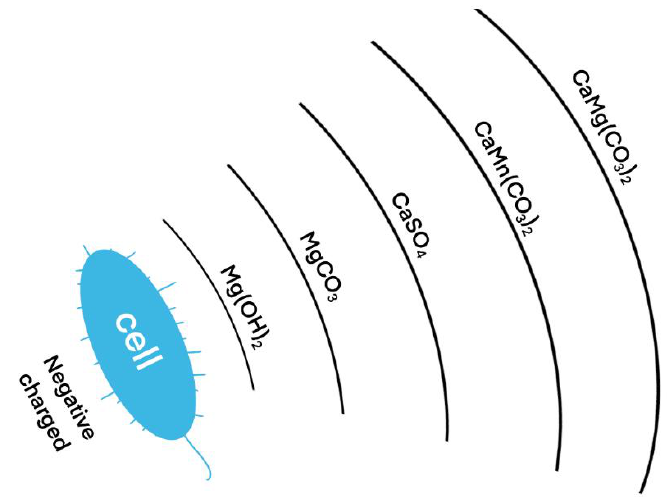
Figure 13. Hypothetical diagram of multilayer precipitation structure.